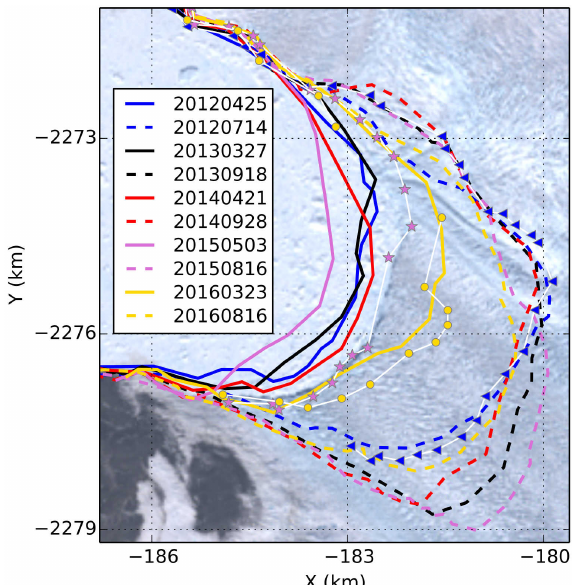
Figure 5. Annual maximum and minimum extents of Jakobshavn Isbræ’s calving front from 2012 to 2016. Solid lines show the glacier front when glacier extent is maximum, and dashed lines when glacier extent is minimum. Glacier front locations are derived from available Landsat-7/8 and Sentinel-2 images in USGS archive. Leg- ends are dates of image acquisition. Lines with triangles, stars, and circles show glacier front locations during TRI campaigns in 2012 (6 August), 2015 (9 June), and 2016 (13 June), respectively. Back- ground for this figure is a Landsat-8 image acquired on 4 June